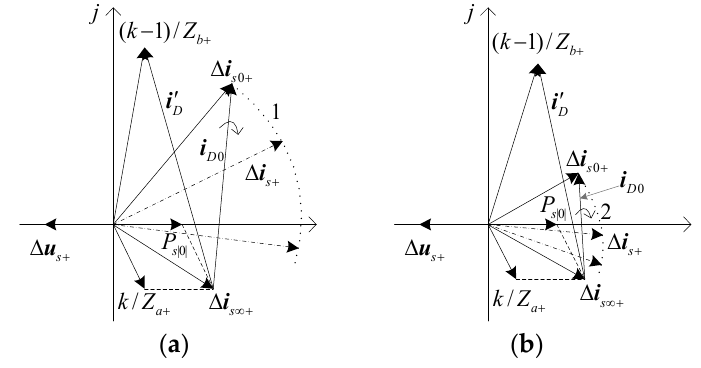
 Z when 0 s  : ( a ) small when s < 0: ( a ) small R cb ; and ( b ) large R cb .  w +